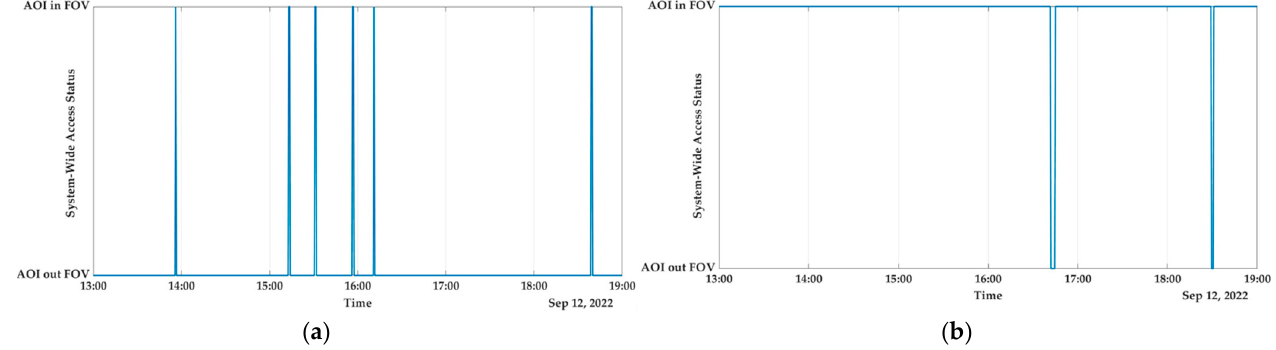
Figure 12. Italy: ( a ) system-wide access status; ( b ) system-wide access status with reconfiguration.